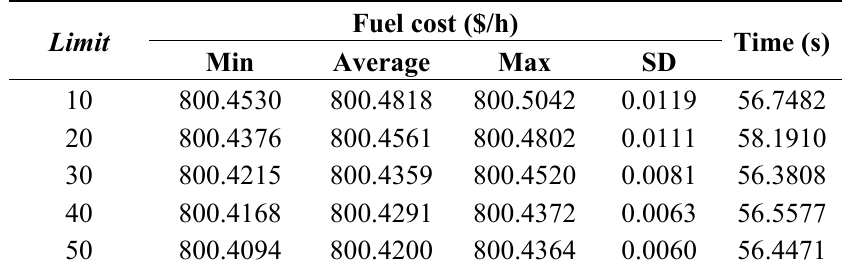
Table 2. Results obtained by the IABC algorithm with different limit values for OPF with total fuel cost.